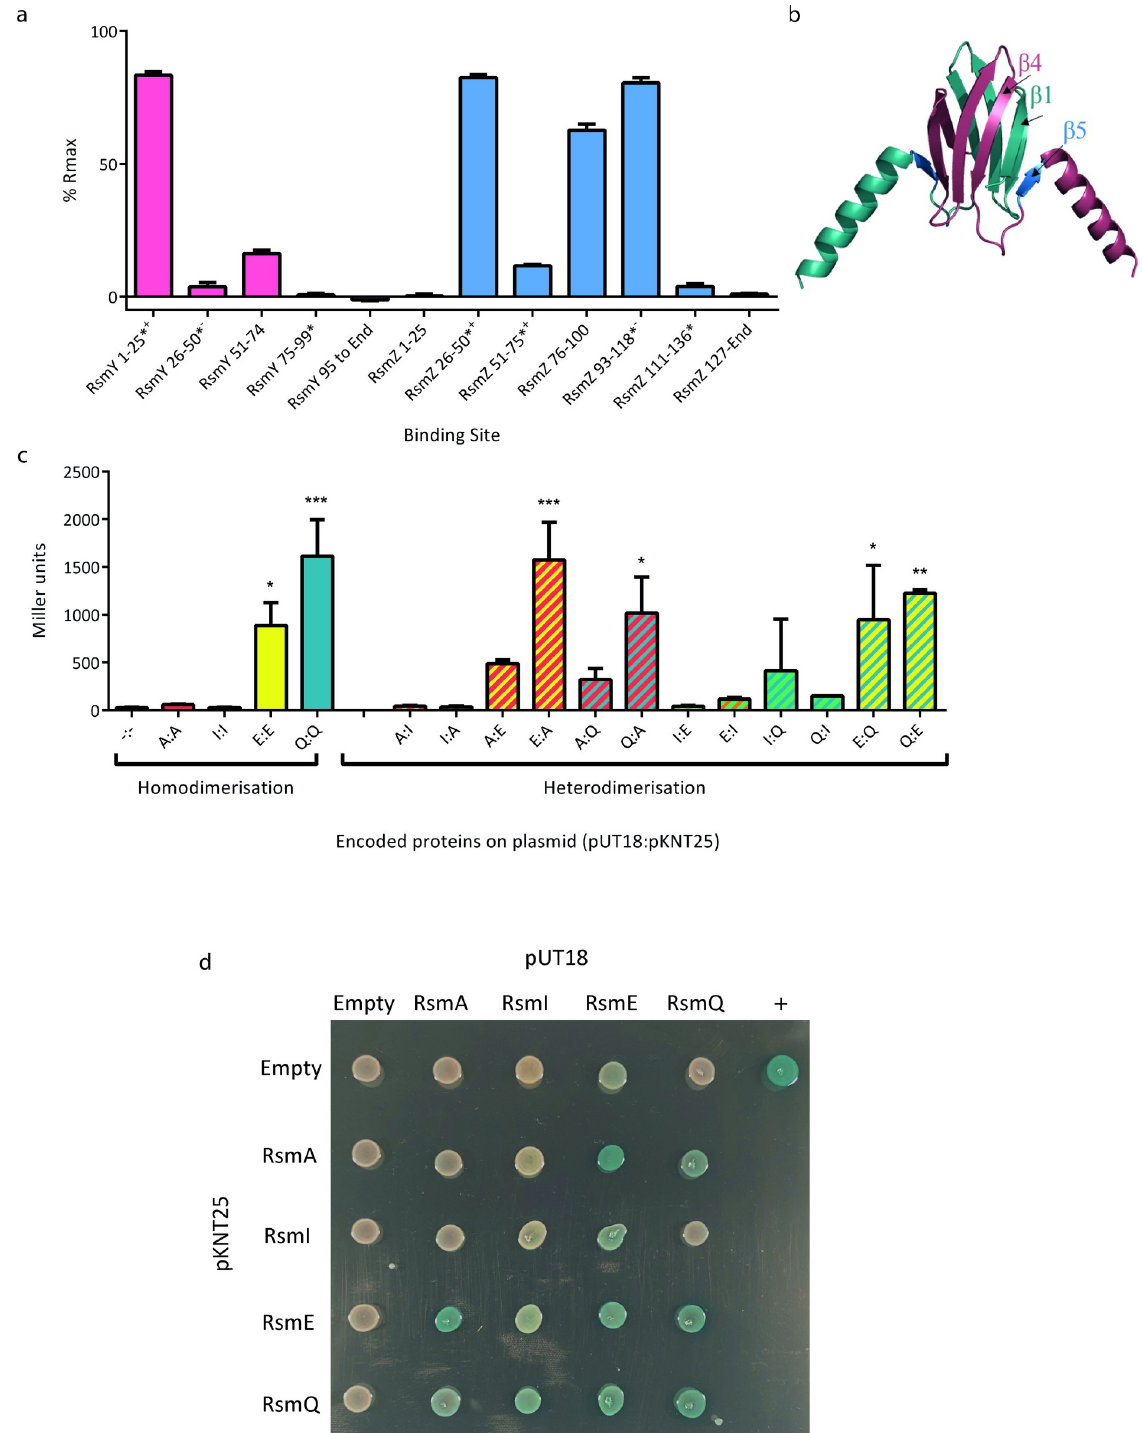
Fig 5. RsmQ can both homo- and heterodimerise. (a) Percentage R max values for RsmQ binding to portions of the ncRNAs RsmY (pink) and RsmZ (blue) showing preferential binding to ssDNAs that contained the binding site in a hairpin loop. Error bars show the standard deviation of 2 replicates and oligos containing a AnGGA binding site are indicated with a ( � ), with those that have the full AnGGA binding site at the top of a stem loop (+) and with the shorter GGA at the top of a stem loop (-) indicated. (b) AlphaFold model of RsmQ suggests that it forms homodimers (monomers shown in contrasting colours), with the RNA-binding region highlighted in marine (B5). (c) Quantitative